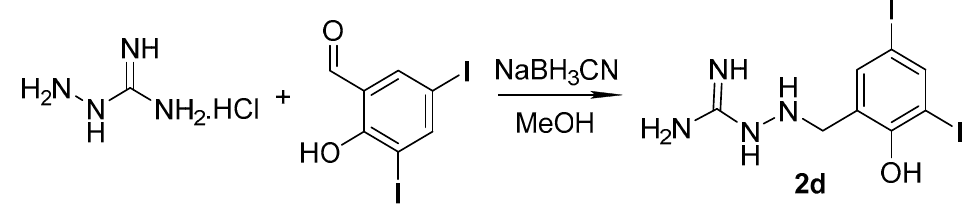
Figure 7. Preparation of synthetic precursors (PCC: pyridinium chlorochromate; DCM: dichloro- methane). 2.2. Microbiology 2.2.1. Antibacterial Activity Based on the literature, we evaluated antibacterial activity of 1 - 3 initially, using the microdilution broth method according to the EUCAST guidelines against four Gram-pos- itive strains: Staphylococcus aureus ATCC 29213, methicillin-resistant Staphylococcus aureus (MRSA) ATCC 43300, Staphylococcus epidermidis ATCC 12228, Enterococcus faecalis ATCC 29212; and four Gram-negative strains: Escherichia coli ATCC 25922, Klebsiella pneumoniae ATCC 10031, Acinetobacter baumannii ATCC 19606, and Pseudomonas aeruginosa ATCC 27853. Results are presented in Table 1. Piperacillin and parent amino compounds (includ- ing AG, 1,3-diaminoguanidine, nitroaminoguanidine, semicarbazide, and thiosemicarba- zide) were involved for activity comparison. Two compounds ( 1c , 1d ) were not evaluated due to solubility problems. The parent amino compounds showed all MIC values above 500 µM (not involved in Table 1), so the activity strongly depends on aldehyde/ketone-derived part of the mol- ecules. Ten target compounds avoided antibacterial properties, i.e., their MIC values were ≥ 500 µM ( 1d , 1e , 1m , 1p , 2d , 2f , 2g , 3a - 3c ; not included in Table 1). Beta-lactam drug pip- eracillin showed higher activity against MSSA, E. faecalis , E. coli as well as P. aeruginosa , but not against S. epidermidis , K. pneumoniae and, of course, MRSA. Regarding compounds 1 - 3 , Gram-positives share a higher susceptibility with MIC from 7.8 µM, while Gram-negative pathogens were significantly more resistant with MIC of ≥ 62.5 µM. The genus Staphylococcus was the most sensitive, importantly, without sig- nificant differences in susceptibility between MSSA and MRSA strains. Of Gram-negative species, P. aeruginosa and A. baumannii were more resistant (MIC from 125 µM). The highest activity was associated with the presence of (5-nitrothiophen-2-yl)me- thylidene (especially against Gram-negative species; 1o ), 5-nitrofurylidene ( 1n , nitrofura- zone 3d , and 3e ) and 3,5-diiodobenzylidene ( 2c ) moieties conferring all a broad-spectrum